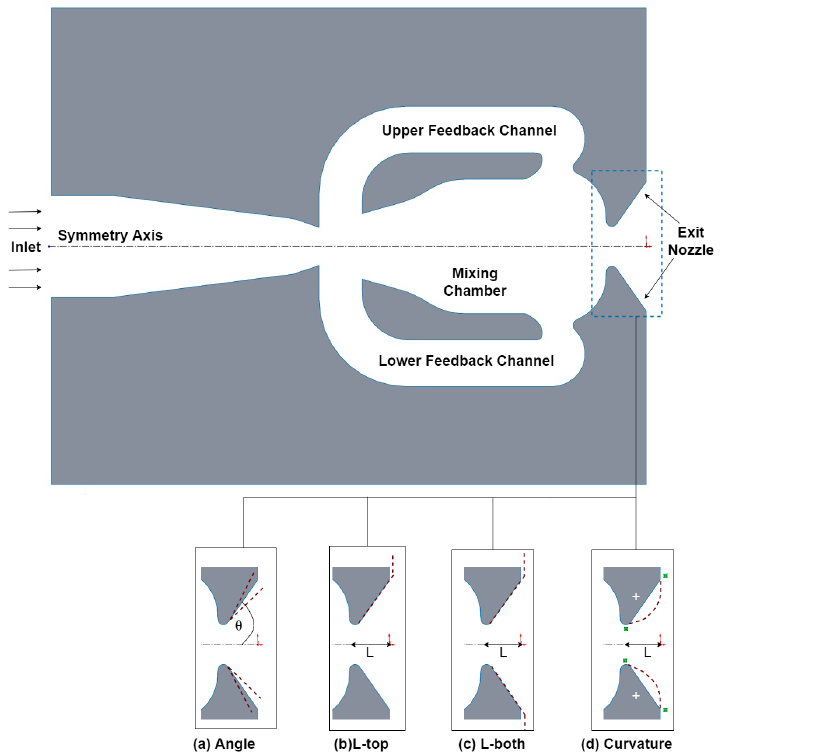
Figure 2. Schematic diagram of the sweeping jet actuator including the tested geometric parameters of the exit nozzle, ( a ) variation in the angle, where θ = half exit nozzle angle, ( b ) top arm length variation, L-top, ( c ) both arm lengths’ variation, L-both, and ( d ) curvature variation, where L = nozzle length, the horizontal distance starting from the throat up to the nozzle